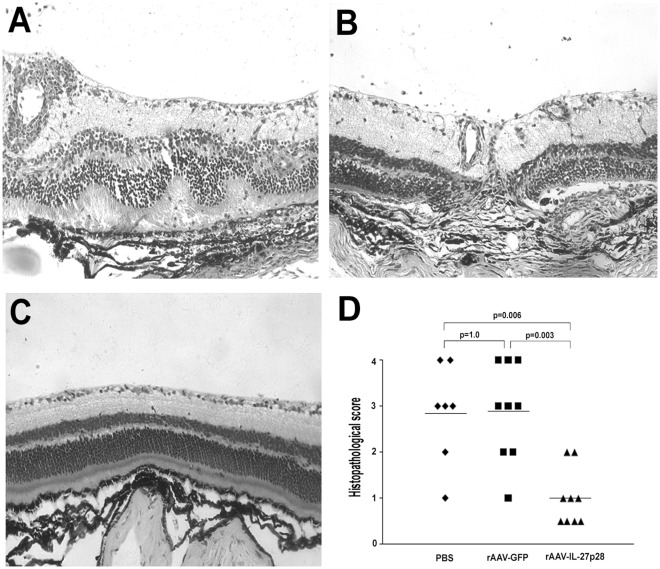
Histological examination on day 14 of EAU.Images of histological analysis show severe retinal folding, destruction, damage of the photoreceptor layer and massive inflammatory cell infiltration in the retina and the choroid, as well as intensive vasculitis in PBS injected eyes (A), moderate infiltration, moderate photoreceptor cell damage and medium-sized granulomas in rAAV2-CMV-GFP injected eyes (B). However, a minor infiltration of cells was observed in the choroid in rAAV2-CMV-mIL-27p28 treated eye (C). (hematoxylin eosin staining, magnification ×200) Comparing PBS injected and rAAV2-CMV-GFP injected eyes with rAAV2-CMV-mIL-27p28 treated eyes showed a reduced EAU histological grade (D, p = 0.006, p = 0.003, respectively). The scores of the three chosen eye section are 4, 3 and 0.5, respectively. Each point is the score of an individual eye, the mean scores of each group are denoted by the horizontal lines.